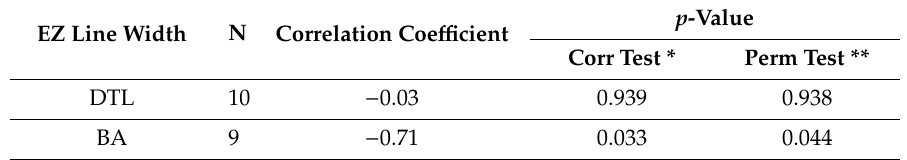
Table 6. Correlations between progression of 30 Hz flicker amplitude versus progression of ellipsoid zone (EZ) line width.